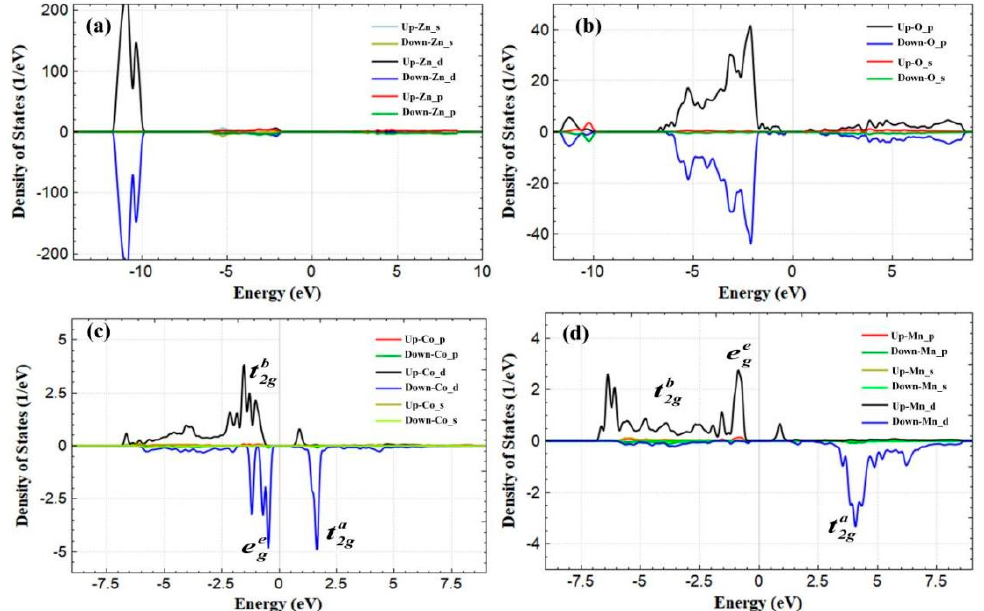
Figure 4. PDOS plots of Co/Mn Co − doped ZnO nanowires: ( a ) PDOS of Zn atoms, ( b ) pure PDOS of O atoms, ( c ) PDOS of Co atoms, ( d ) PDOS of Mn atoms.